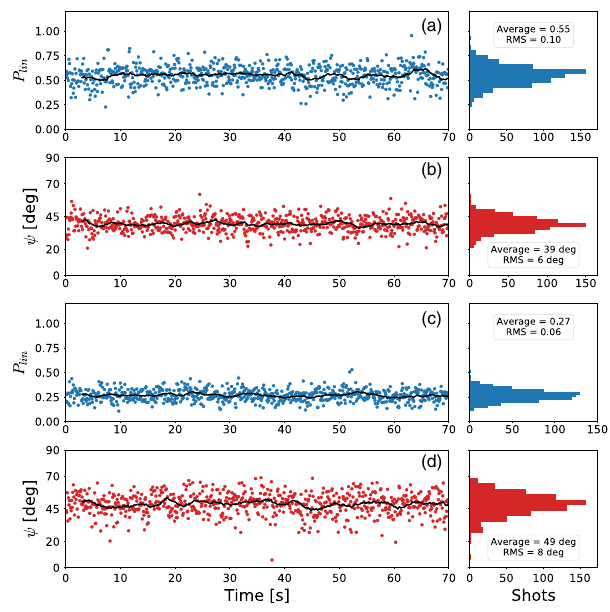
FIG. 18. Degree and direction of the linear polarization component for the XPU with circular polarization in SASE. (a, b) refer to the consecutive configuration, obtained using 4 undulators with CR and 1 undulator with CL polarization. (c, d) refer to the distributed configuration with 6 undulators. The lines represent the moving average over 30 shots of the reported quantities. Note that, in the case of SASE, the distributed configuration leads to a lower degree of linear polarization than the consecutive